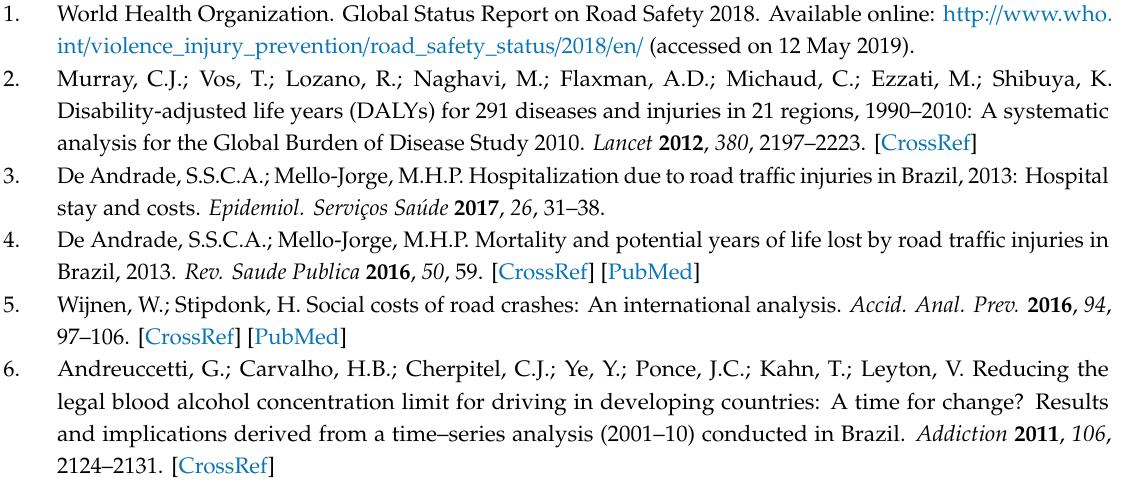
Table S1: Descriptive Analysis of Sociodemographic and Behavioral Characteristics in the Sample Study, by Macro–region of Brazil. National Health Survey,